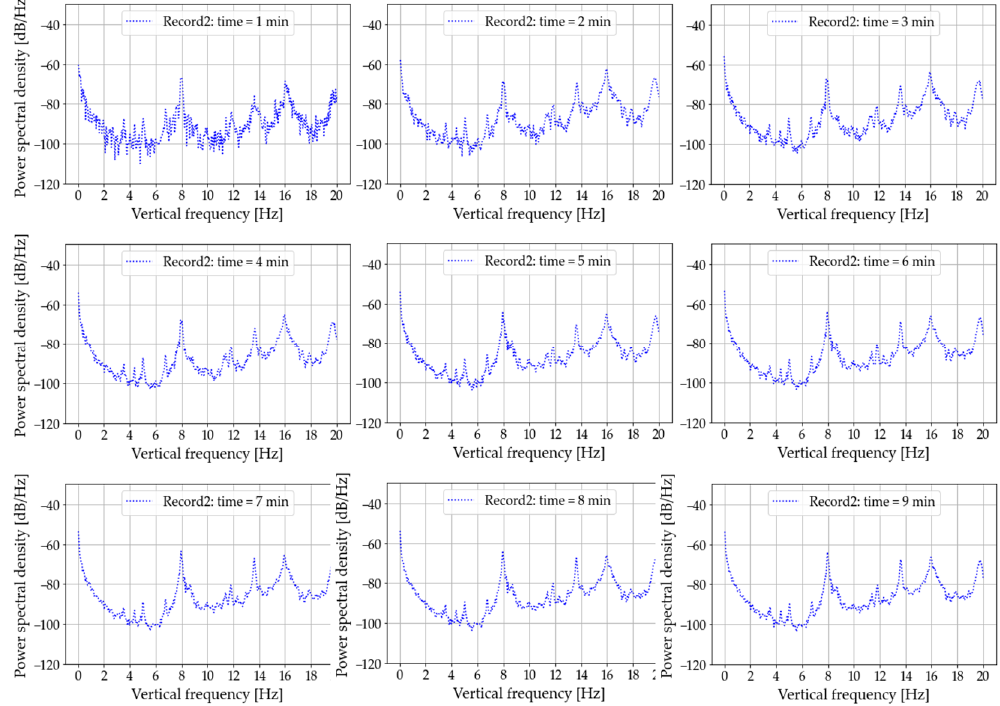
Figure 15. Power spectral density of the last nine vertical frequency observations of the Uninorte bridge.